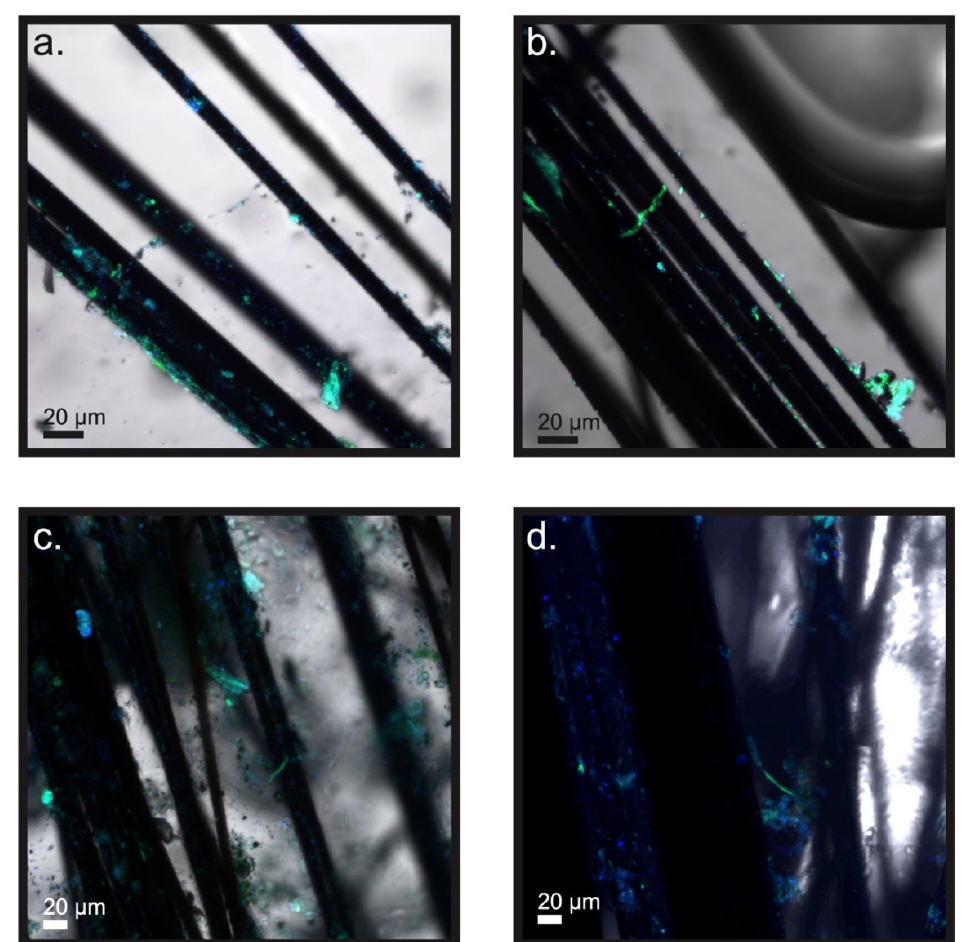
Figure 6. ( a , b ) Confocal laser scanning microscope images showing filaments and colonies belonging to the Desulfobulbaceae family on the surfaces of anode carbon fibers of reactor A. ( c , d ) Confocal laser scanning microscope images showing filaments and colonies belonging to the Desulfobulbaceae family on the surfaces of anode carbon fibers of reactor B. Alexa Fluor 488, green was catalytically deposited alongside with the DSB706-HRP probe and DAPI, and blue was applied as a counterstain. CARD-FISH revealed that the observed filaments reacted positively with the DSB706 probe universally, affirming that all forms belong to the family of Desulfobulbaceae (Figures 6 and 7). The anodic carbon fibers also hosted various non-filamentous colonies or aggregates of cells in this family (Figures 6 and